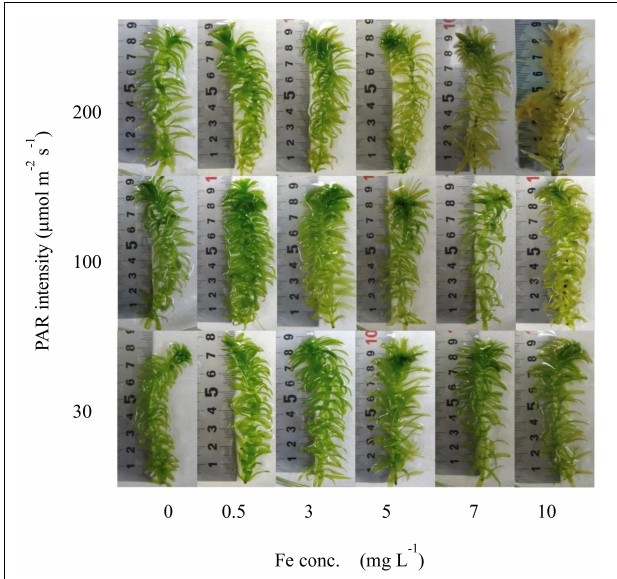
FIGURE 2 | Visual conditions of plant shoots from the laboratory experiment after 7 days’ exposure to different light intensity and Fe conditions.